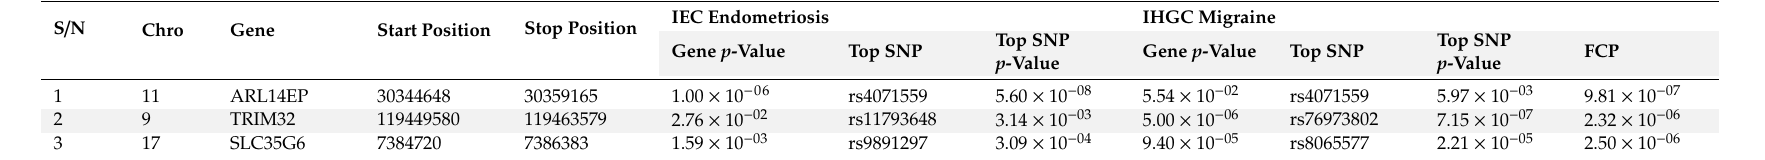
Table 4. Genome-wide significant genes overlapping endometriosis and migraine in gene-based association analyses.